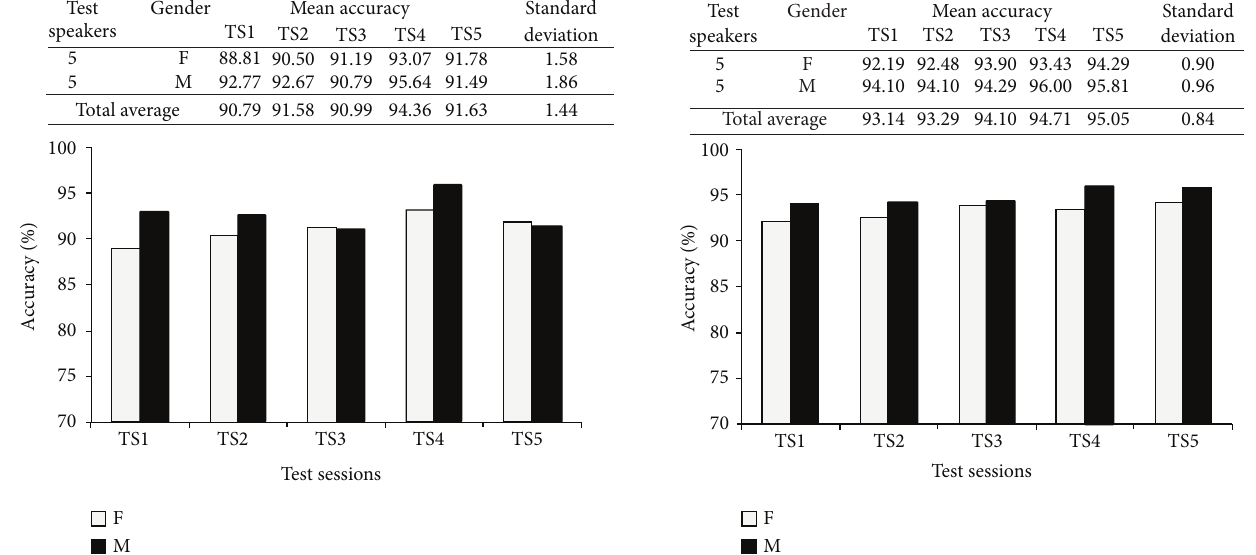
Figure 19: Accuracy of the speaker-adaptive Mixtec ASR system. errors in the recognition tasks (to measure the accuracy), the same kind of errors was identified to assess the TWER. In